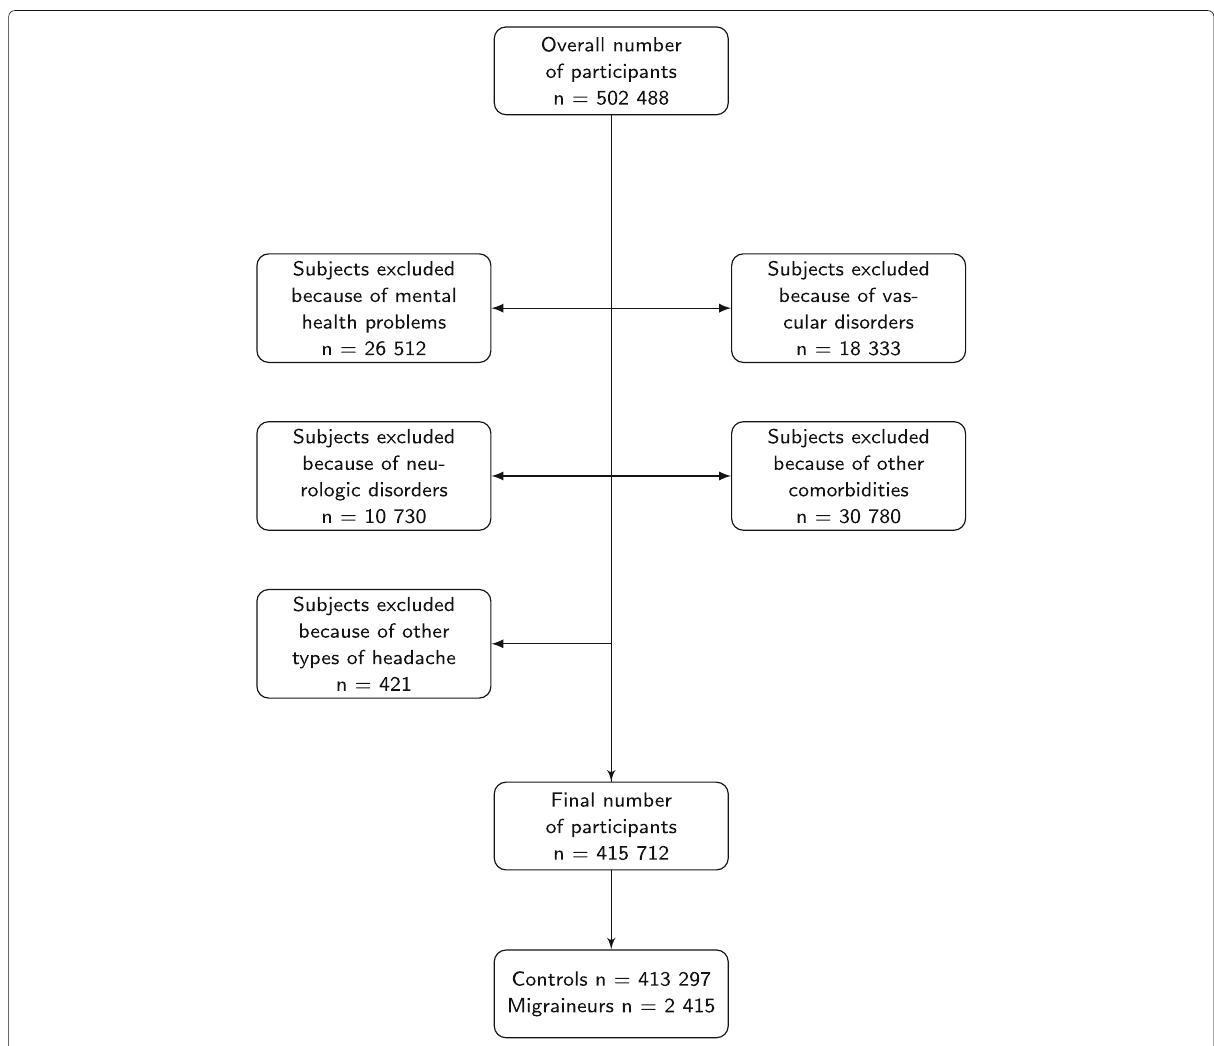
Fig. 2 Flow chart of the exclusion process